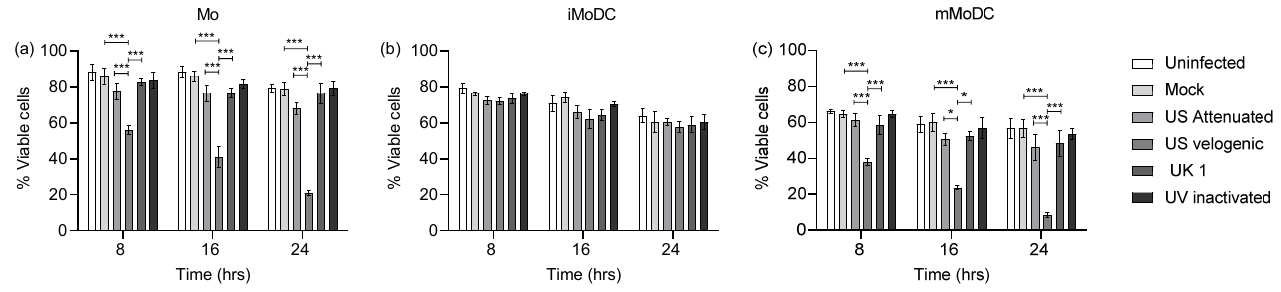
Figure 3. Time kinetics of the viability of EAV infected Mo and MoDC. Mo, immature (iMoDC) and mature (mMoDC) were inoculated at MOI of 5 with different strains of live or UV inactivated EAV. Cultures were incubated 37 °C in 5% CO 2 for ( a ) 8 h, ( b ) 16 h, and ( c ) 24 h post infection (hpi). Controls included uninfected cultures (media only) and mock infected cultures. Cells were stained with the violet dead cell stain and analysed by flow cytometry. Data are represented as the mean percentage viable cells ± SEM ( n = 4). Statistical significance was determined using a 2-way ANOVA with Bonferroni posttest to compare replicate means. * and *** indicate significant differences between sample means where p < 0.05 and 0.0001, respectively.